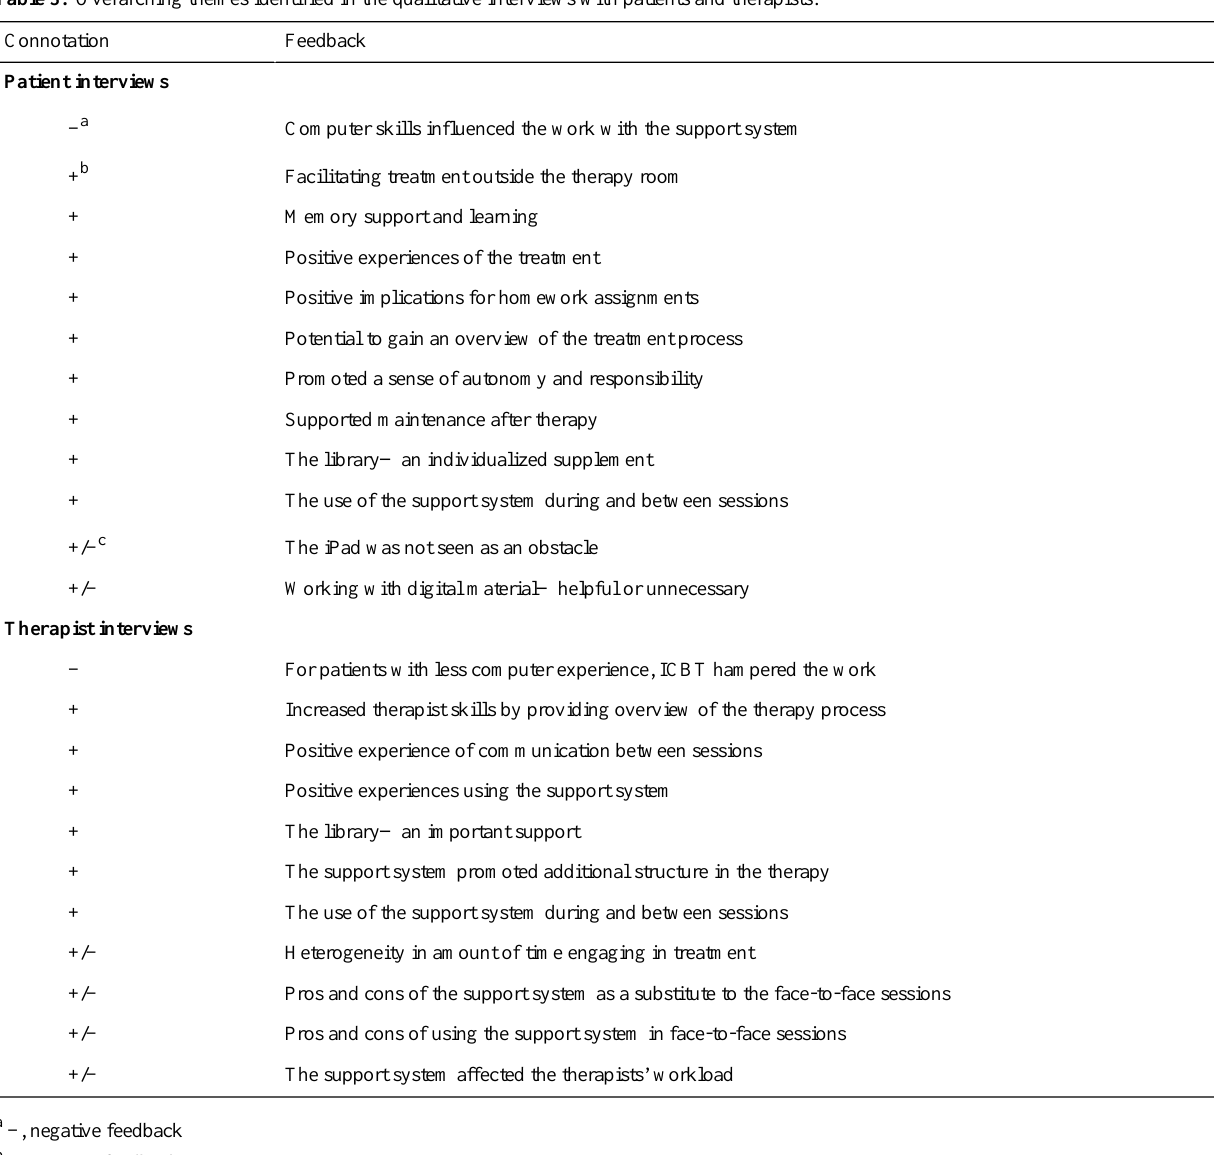
Table 3. Overarching themes identified in the qualitative interviews with patients and